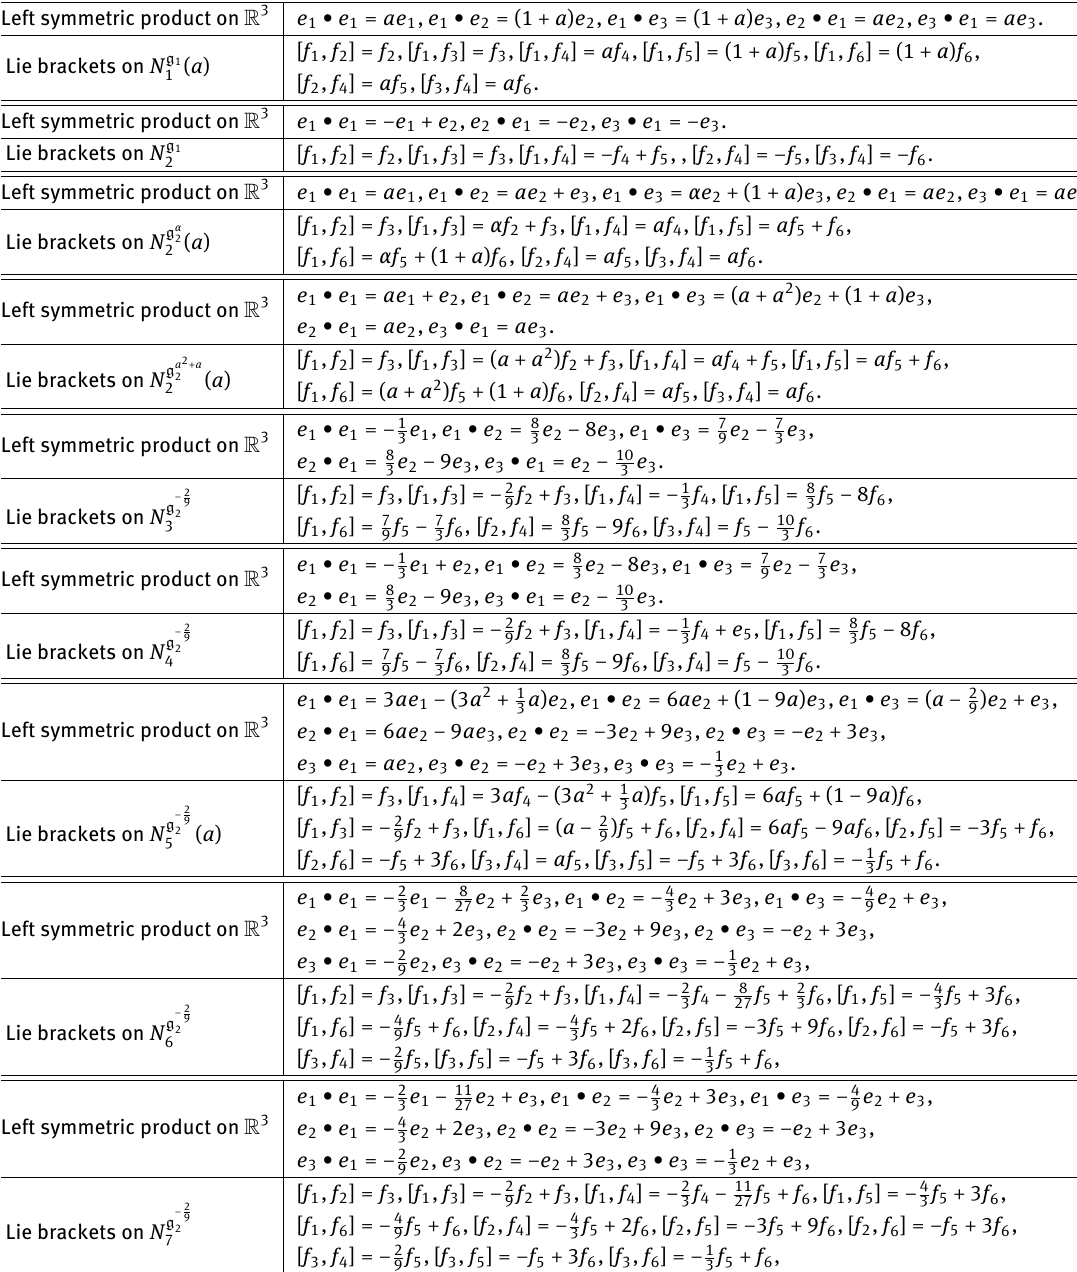
Table 1: Three dimensional Novikov algebras and their associated phase Lie